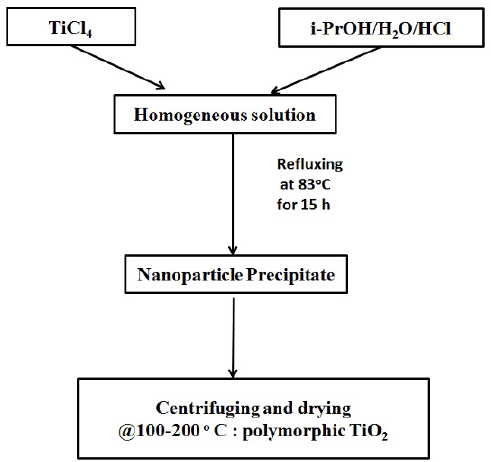
Figure 5. Synthetic diagram for water-based ambient condition sol polymorphic TiO 2